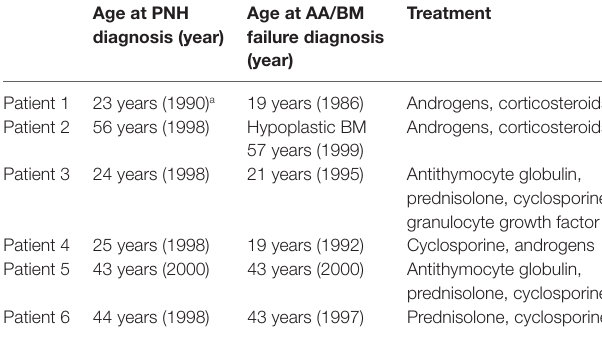
Table 1 | Patients and